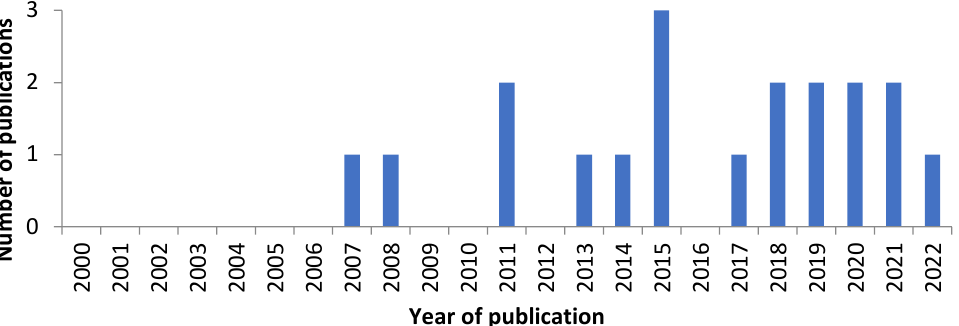
Figure 2. The number of journal articles published between 2000 and 2022 containing the phrase “bryophyte endophyte compounds”, “liverwort endophyte compounds”, “moss endophyte com- pounds”, and “hornwort endophyte compounds” within the title, abstract, or as a keyword (data based on a search from PubMed, 14 January 2023).